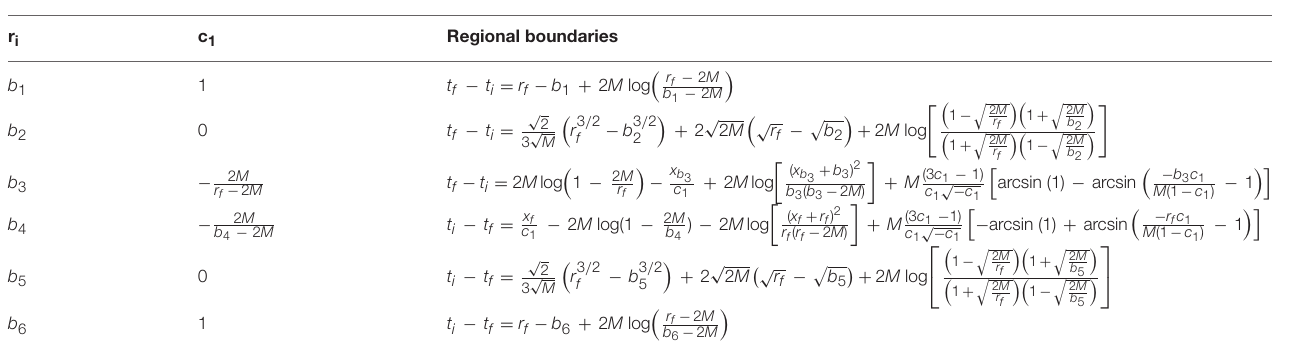
At each region boundary b j (j 2 5 ) the equations converge to the form given in Table 2 . All discontinuities cancel resulting in smooth transitions between regions without singularities. = − TABLE 2 | Region boundaries for the equation of motion (Equation